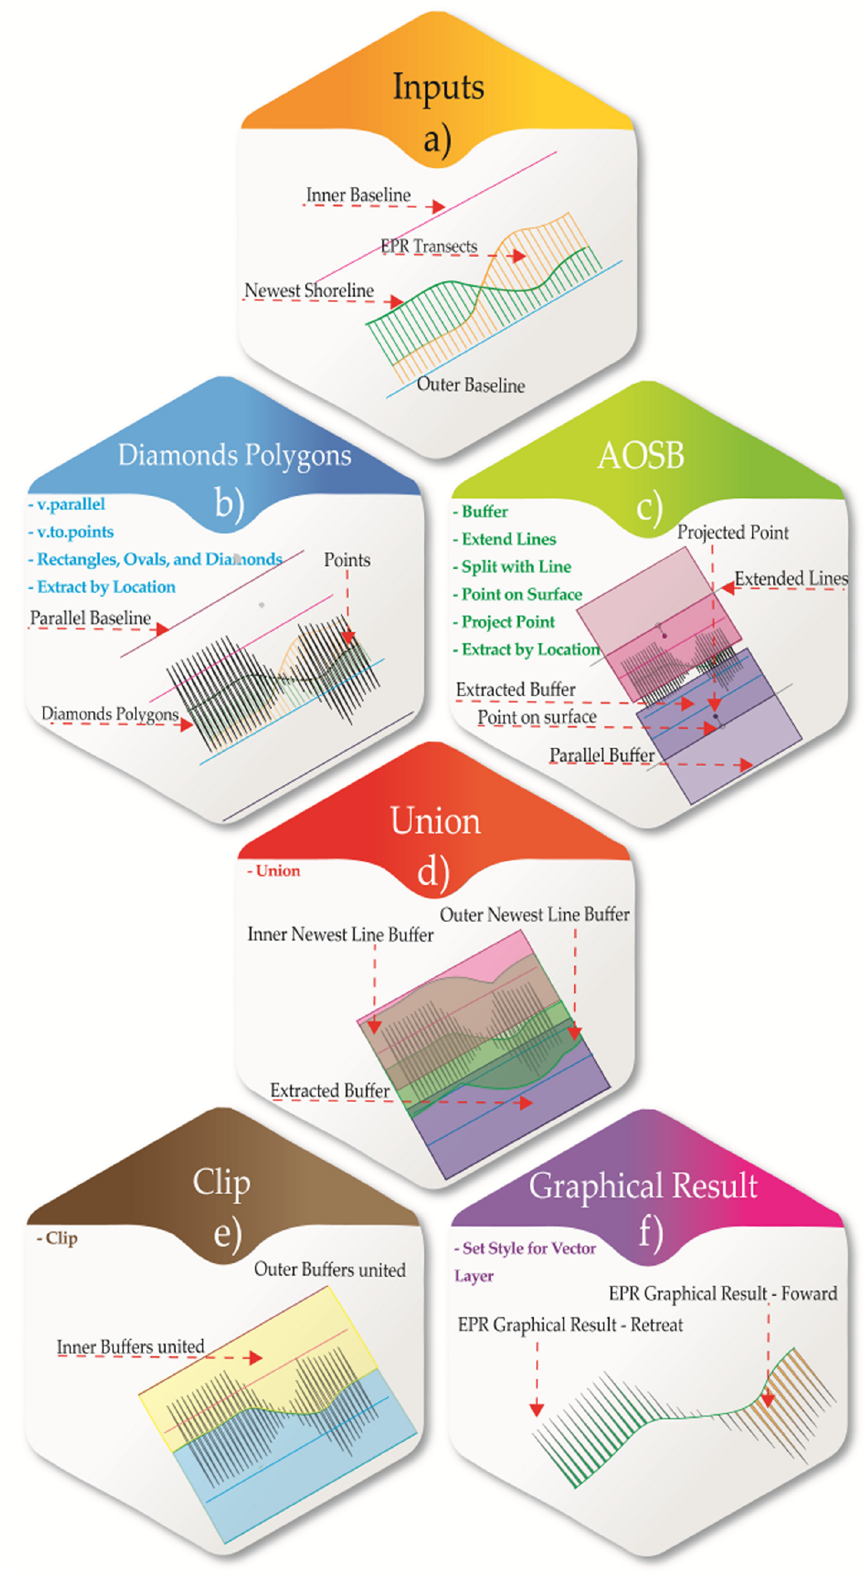
Figure 4. Graphical visualization process of EPR4Q tool: ( a ) inputs (inner and outer baseline, EPR transects, and shorelines); ( b ) diamond polygons ( v.parallel tool , v.to.points tool , and Extract by Location tool ); ( c ) alternative one-side buffer ( Buffer tool , Extend Lines tool , Split with Line tool , Point on Surface tool , Project Point tool , and Extract by Location tool ); ( d) union; ( e ) clip; ( f ) graphical result ( Set Style for Vector Layer tool